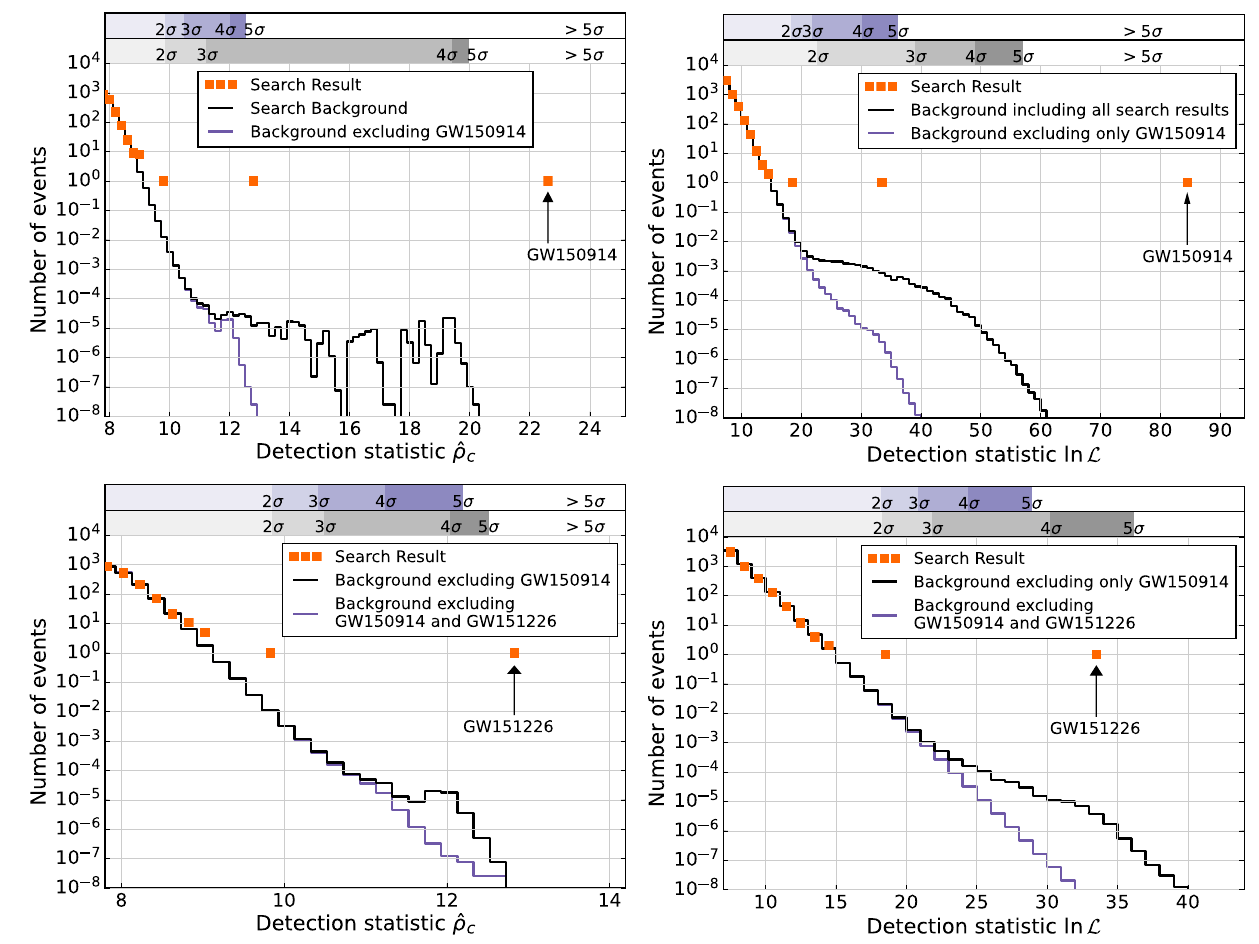
FIG. 3. Search results from the two analyses. The upper left-hand plot shows the PyCBC result for signals with chirp mass M > 1 . 74 M m m 2 M f > 100 Hz, while the upper right-hand plot shows the GstLAL result. ⊙ (the chirp mass of an 1 ¼ 2 ¼ ⊙ binary) and peak In both analyses, GW150914 is the most significant event in the data, and it is more significant than any background event in the data. It is identified with a significance greater than 5 σ in both analyses. As GW150914 is so significant, the high significance background is dominated by its presence in the data. Once it has been identified as a signal, we remove it from the background estimation to evaluate the significance of the remaining events. The lower plots show results with GW150914 removed from both the foreground and background, with the PyCBC result on the left and the GstLAL result on the right. In both analyses, GW151226 is identified as the most significant event remaining in the data. GW151226 is more significant than the remaining background in the PyCBC analysis, with a significance of greater than 5 σ . In the GstLAL search, GW151226 is measured to have a significance of 4 . 5 σ . The third most significant event in the search, LVT151012, is identified with a significance of 1 . 7 σ and 2 . 0 σ in the two analyses, respectively. The significance obtained for LVT151012 is not greatly affected by including or removing background contributions from GW150914 and